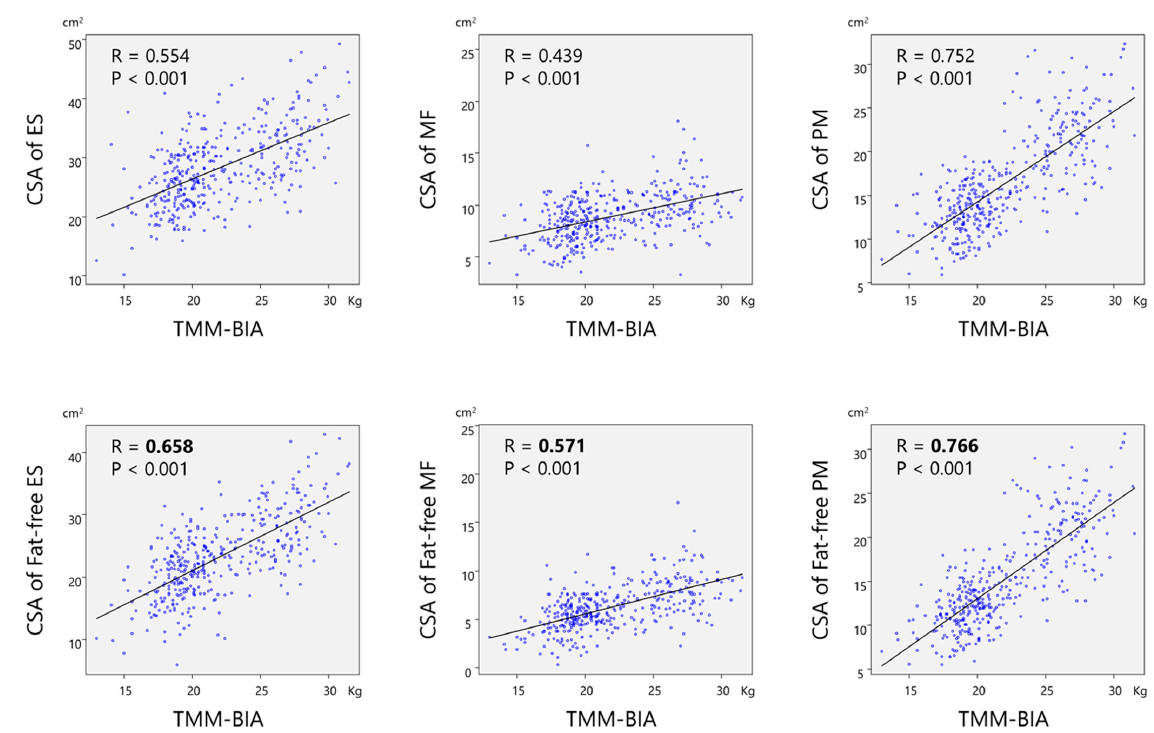
Figure 4. Correlations between TMM–BIA and the CSA of each individual PVM (upper row, total; lower row, excluding intramuscular fat). The CSA of the PM showed a strong correlation with the TMM–BIA (total, r = 0.752; fat-free, r = 0.766), whereas the CSA of MF, the smallest muscle of the PVM, showed a moderate correlation (total, r = 0.439; fat-free, r = 0.571). In addition, the CSA of ES had a moderate to strong correlation to the TMM–BIA (total, r = 0.554; fat-free, r = 0.658), respectively. TMM–BIA, trunk muscle mass measured by bioelectrical impedance analysis; CSA, cross-sectional area; PVM, paravertebral muscle; ES, erector spinae; MF, multifidus; PM, psoas Table 2. Correlations between TMM–BIA and each PVM with and without intramuscular fat. CSA, cm 2 R with TMM–BIA p -Value